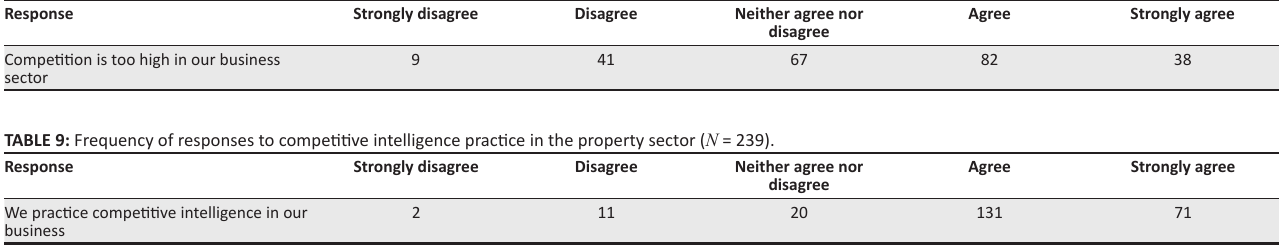
TABLE 8: Frequency of responses to level of competition in the property sector ( N = 239).